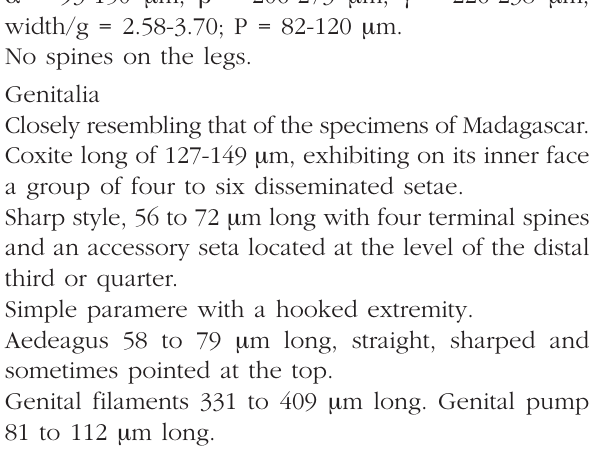
Fig. 4. – Sergentomyia goodmani comorensis n. ssp. male. A: ciba- rium and pharynx; B: palp; C: antennal seg- ments III, IV and V; D: wing; E: